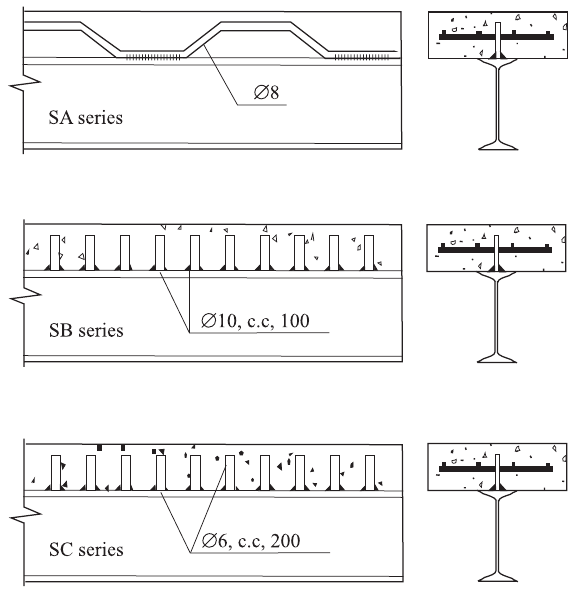
Fig. 6. General view of the